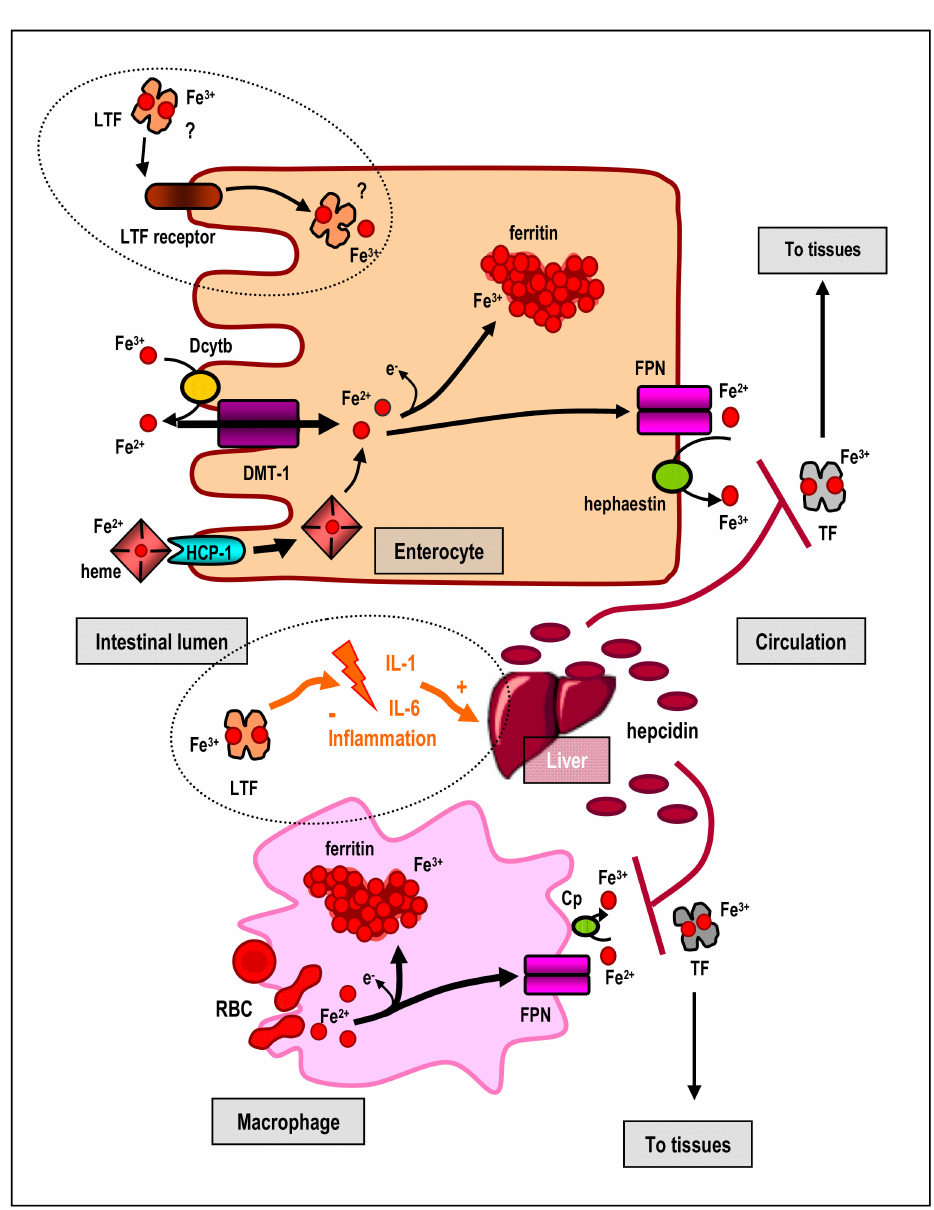
Figure 2. Processes of iron absorption in small intestine enterocytes and release from hepatic/spleen macrophages. For uptake of non heme Fe 3+ ions, their reduction to Fe 2+ is essential, involving Dcytb. Fe 2+ ions are transported into cells by means of DMT-1 transporter and here may be stored in a form of ferritin (after prior oxidation) or released into circulation by FPN transporter (after prior oxidation by membrane hephaestin or serum Cp). In circulation, Fe 3+ ions bind to TF that transports them to all tissues; in the left upper corner (in the circle) a possible participation of LTF in the process of iron absorption is presented. Iron from waste, recycled erythrocytes, is accumulated in hepatic/splenic macrophages (reticuloendothelial system) as ferritin or, as necessary, released from cells by means of FPN, bound to TF and transported into tissues. In both cases, hepatic hepcidin (induced among other by proinflammatory cytokines) inhibits activity of FPN and iron release into circulation. LTF inhibits expression of proinflammatory cytokines and in this way inhibits expression of hepcidin, ensuring activity of FPN and iron absorption and its release from body resources (in the middle of figure, in the circle). Cp–ceruloplasmin, Dcytb–duodenal cytochrome b, DMT-1–divalent metal